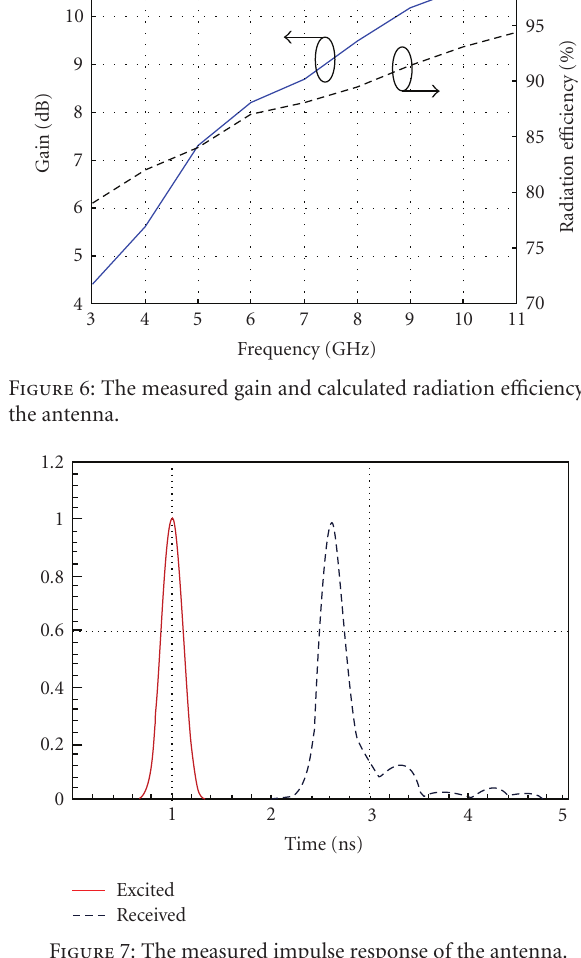
Figure 7: The measured impulse response of the